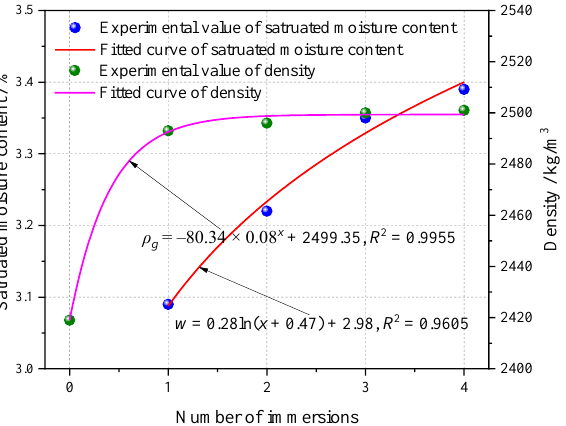
Figure 11. Saturated moisture content- and density-immersion times. Note: w in the fitting equation is the saturated moisture content, ρ g is the density of the gangue, and x is the number of immersions. As shown in Figure 11, with an increase in the immersion time, the saturated mois- ture content and density of the gangue increased gradually, and the increase in amplitude decreased gradually. The change law was fitted using logarithmic and exponential func- tions. From one to two times immersion, the saturated moisture content of the gangue increased from 3.09 to 3.25%, an increase of 0.16%. From two to three times immersion and from three to four times immersion, the increase in the saturated moisture content of the gangue was 0.08 and 0.06%, respectively. During repeated drying ‒ wetting, on the one hand, the dissolution and scouring of water increased the original pores and fractures in the gangue; on the other hand, the clay minerals in the gangue expanded after encounter- ing water, limiting the growth of pores and fractures. The densities of the gangue were 2419, 2493, 2496, 2500, and 2501 kg/m 3 , respectively, after drying and one time immersion. The gangue density increased by 3.39% from the dry state to four times immersion. As the external volume of the gangue remained unchanged, the saturated moisture content and quality of the gangue increased, and thus the measured gangue density increased. 4.2. Compaction Characteristics The stress – strain relationship of the gangue with different immersion times is shown in Figure 12 (the final stress is 2 MPa).